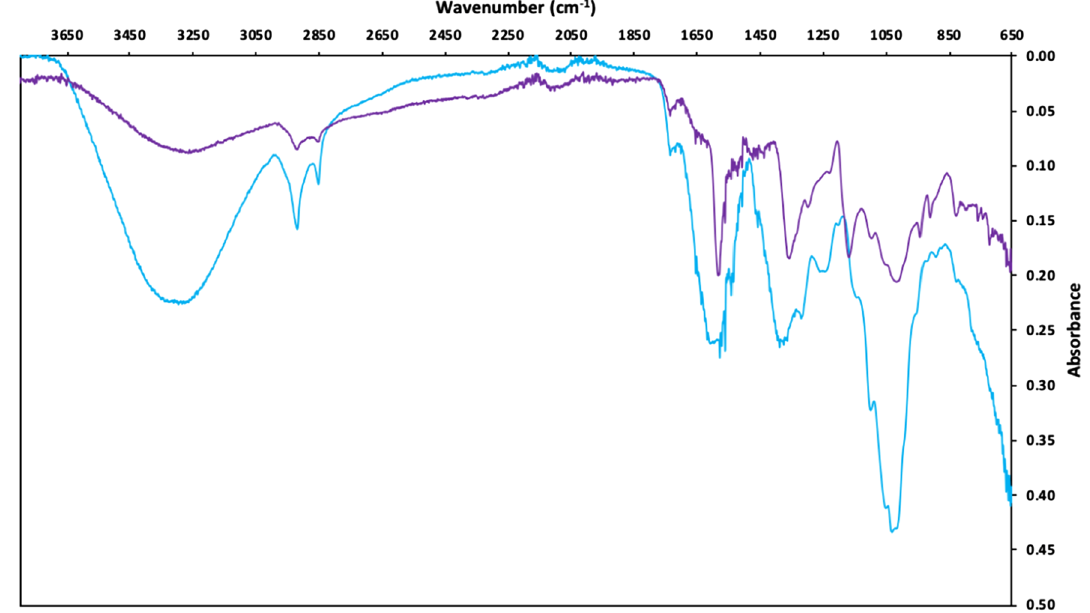
Fig. 10 FTIR spectra of IA before (blue) and after (purple) adsorption of MV2B